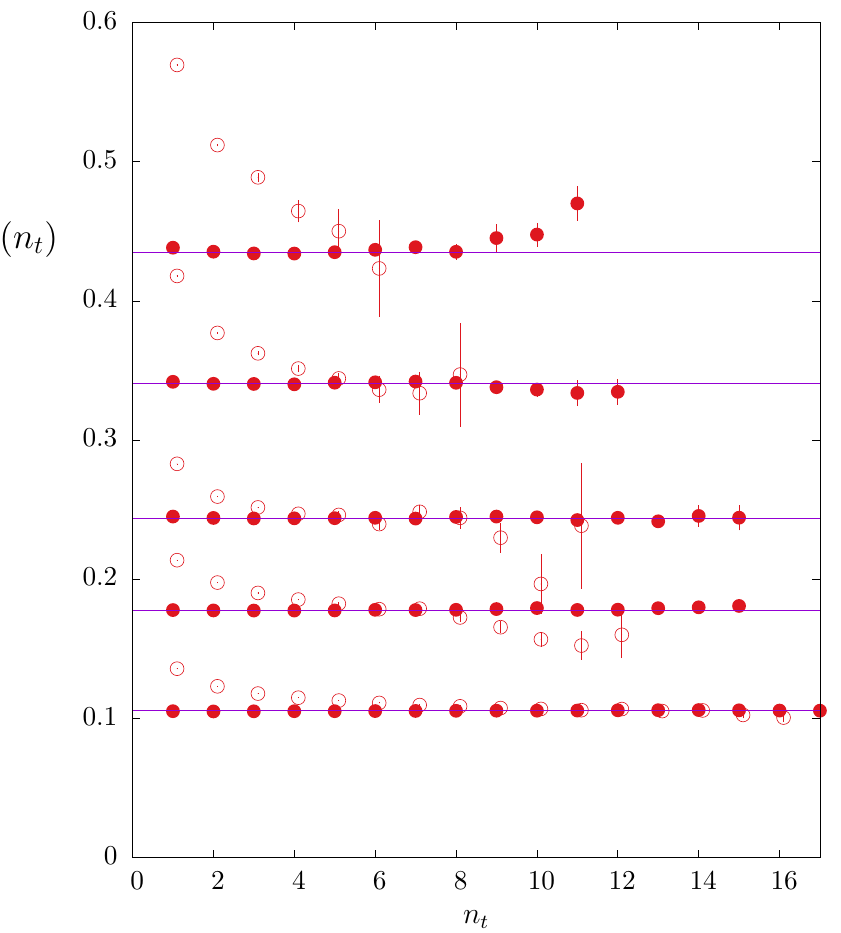
Figure 16 . E(cid:11)ective energies of (cid:13)ux tubes of length l = 18 ; 26 ; 34 ; 46 ; 58 in SU(2) at (cid:12) = 16 : 0, as a function of n t = t=a for (cid:13)ux in the fundamental, (cid:15) , and in the adjoint, (cid:14) . Adjoint values have been rescaled to asymptote to the fundamental energies. Lines shown are (fundamental) energy